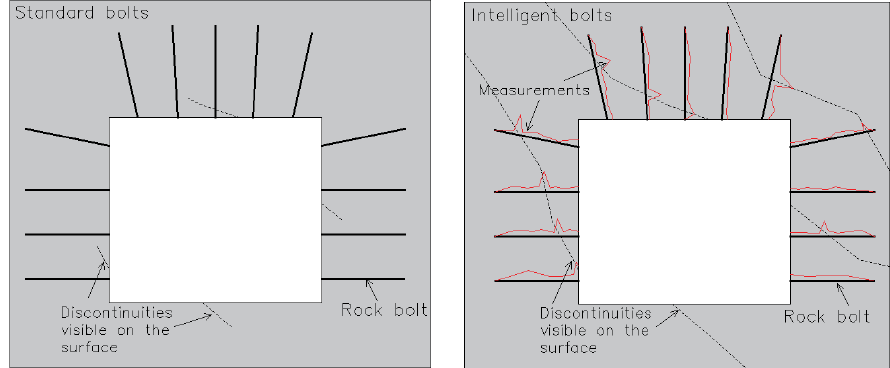
Figure 16. Possibility of identification of rock mass fracture with standard rock mass support ( left ) and instrumented rock bolts ( right ).